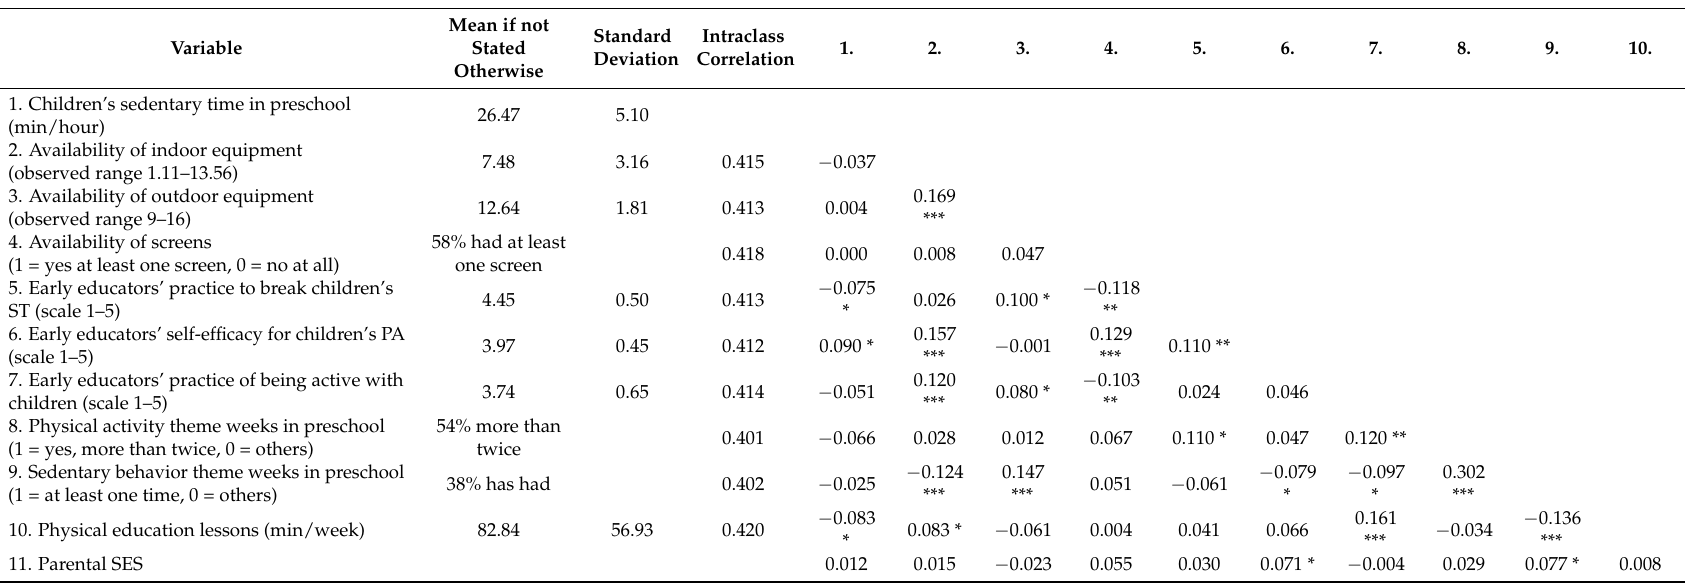
Table 1. Descriptives and the Spearman correlations between the measures used in the study (listwise n = 577). SES: Socioeconomic status.